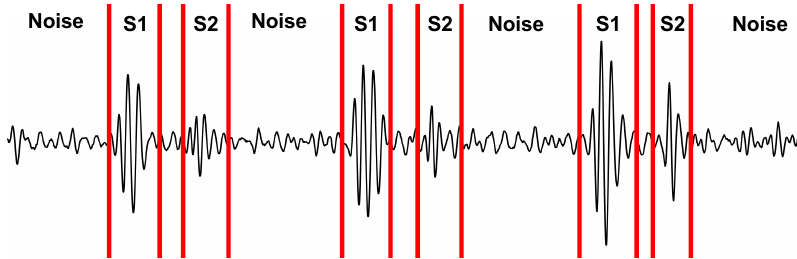
Figure 10. Depiction of the signal segmentation used for calculating the